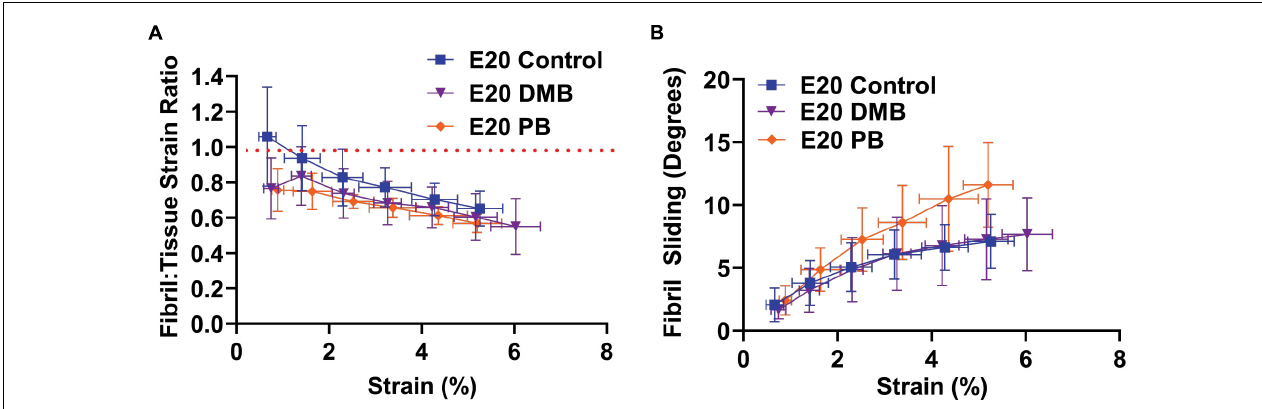
FIGURE 6 | Multiscale mechanical response at E20 (HH46) as a function of applied tissue strain after immobilization treatments. (A) The fibril:tissue strain ratio was significantly lower with flaccid paralysis (PB) treatments in comparison to the control tissue ( p < 0.05). No significant difference was observed between the rigid paralysis (DMB) and the vehicle control tissue ( p = 0.106). (B) All samples displayed an increase in fibril sliding angle with applied stress. No significant group effects were observed under paralysis conditions in comparison to vehicle controls (PB vs. Control: p = 0.10, DMB vs. Control: p = 0.78). Significance was tested with a linear mixed model accounting for correlated strain increments per specimen as a covariate. Data represented as mean ± standard deviation. Data represented as mean ± standard